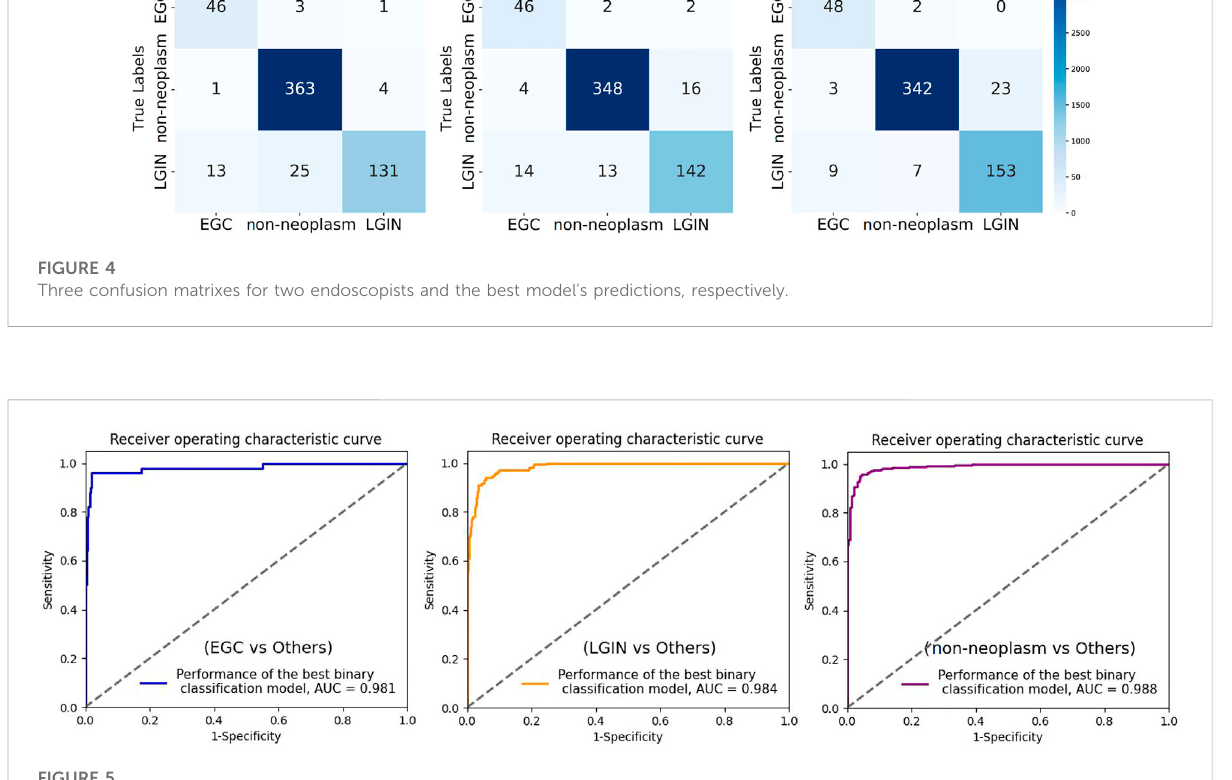
FIGURE 5 ROC curve for thethree best binary classi fi cation models. ROC, receiver operating characteristic; AUC,area under thecurve; EGC,early gastric cancer; LGIN, low-grade intraepithelial